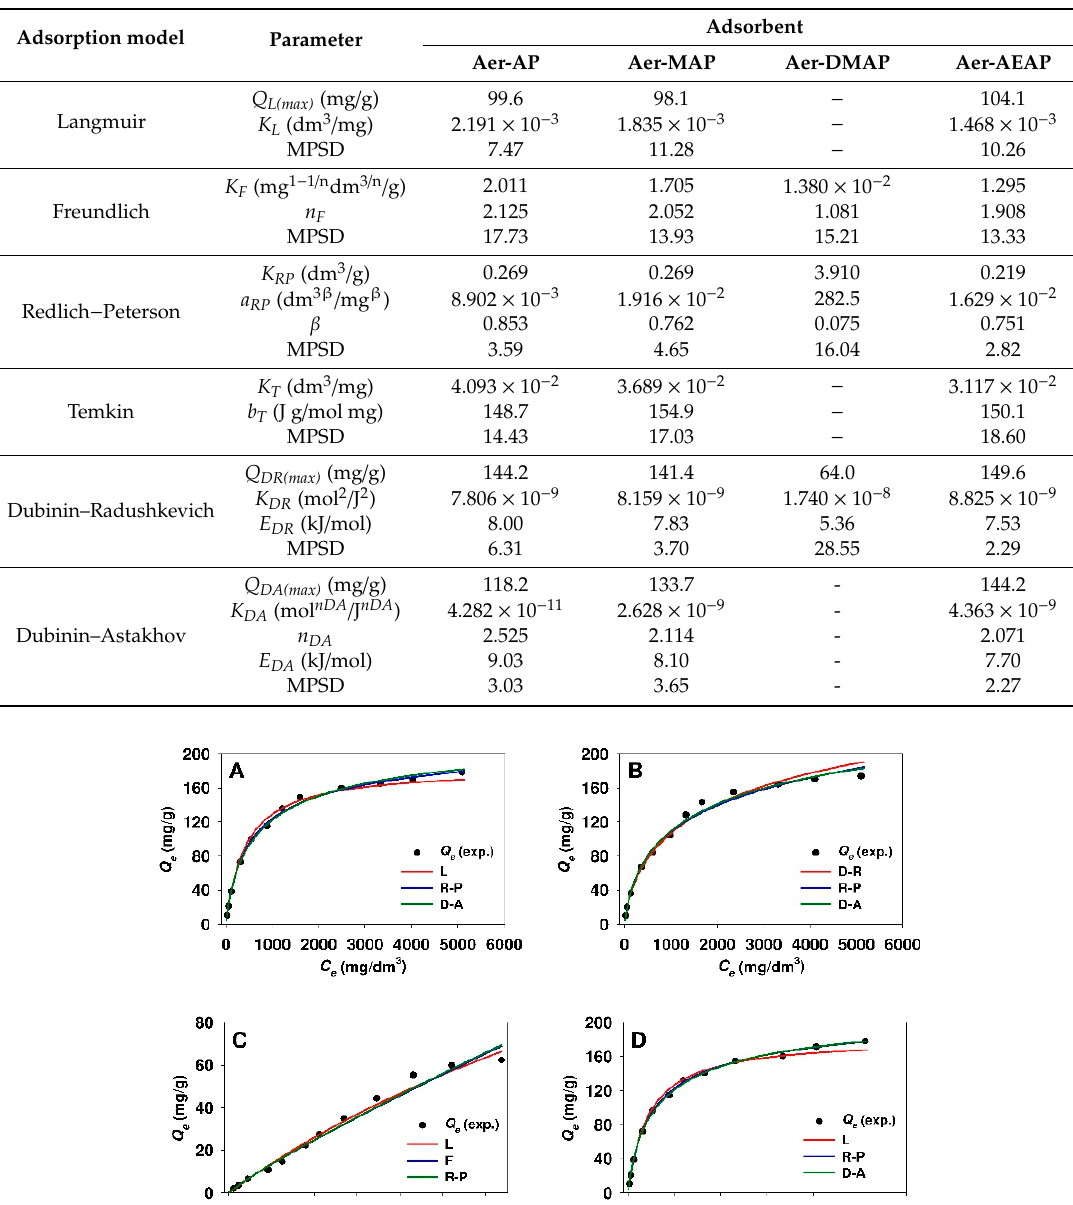
Table 6. Isotherm parameters calculated from nonlinear fitting analysis for 18 β -glycyrrhetinic acid adsorption onto non-porous silica functionalized with various amine groups.